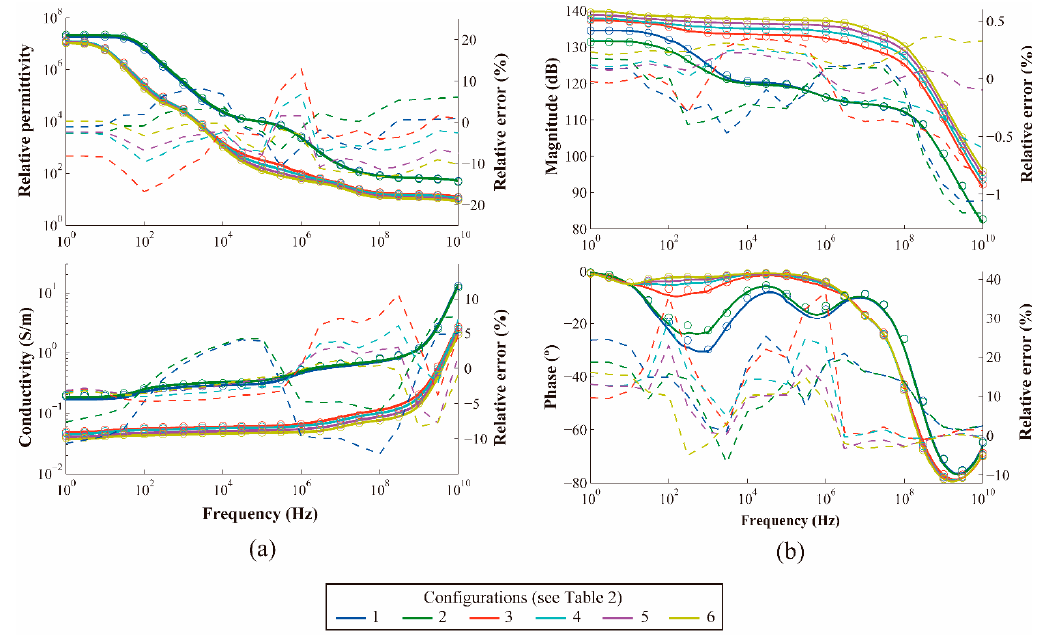
Figure 6. Comparison of the analytical model (circles) and 2D FEA simulation (solid). ( a ) Relative permittivity and conductivity. ( b ) Bioimpedance. In ( a ) and ( b ), dashed lines represent the relative error.